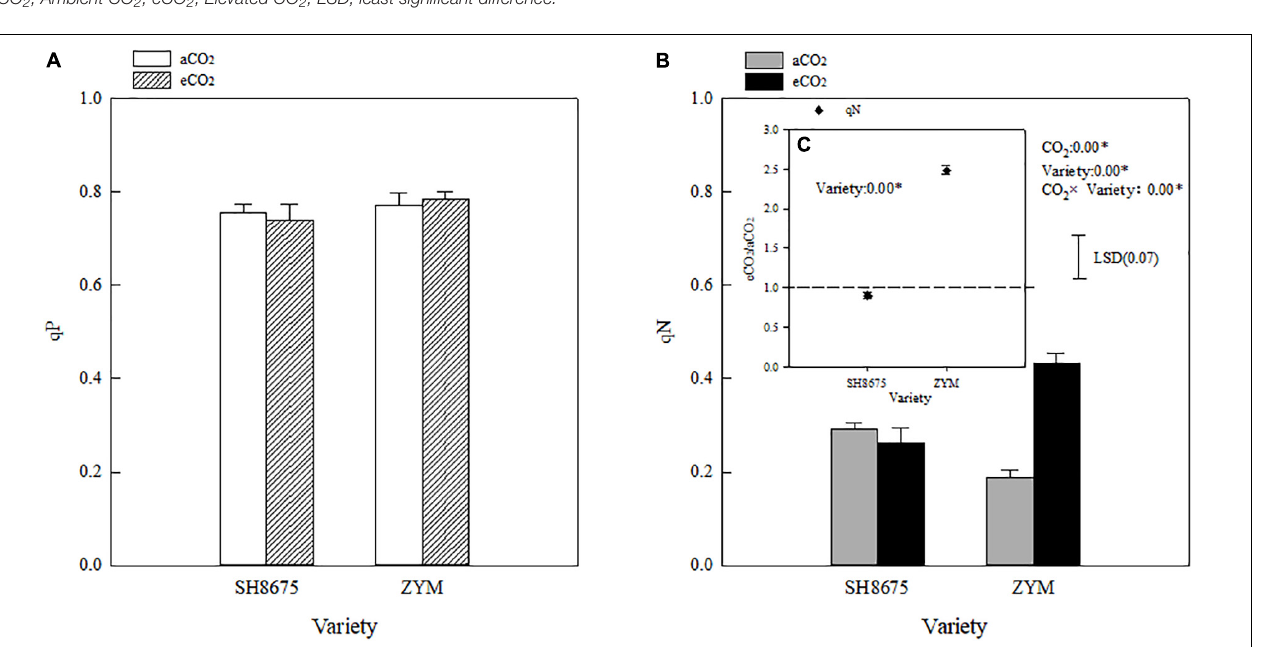
FIGURE 3 | Effects of eCO 2 on the qP and qN of two winter wheat varieties (A–C) . Measurements were carried out on intact flag leaves. Data represent the mean of three plants from each plot ± SD (standard error) bars. ANOVA results with * indicate significance at p < 0.05. Vertical bar in Figure 3B indicates LSD ( p < 0.05) for qN. Differences in the qN of the varieties in response to eCO 2 is showed in Figure 3C